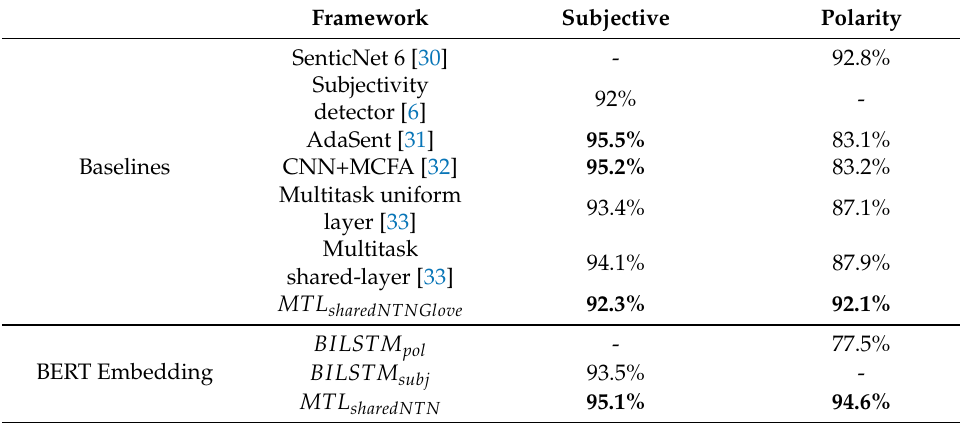
Table 2. Accuracy comparision of different